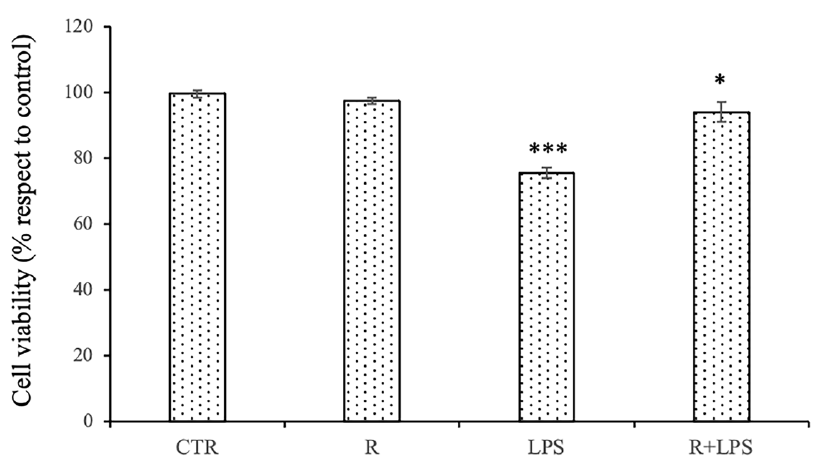
Figure 1. Effects of resveratrol and LPS treatment on cell viability. N13 microglial cells were treated with resveratrol (10 µ M) alone or in presence of LPS (100 ng/mL) for 72 h. Cell viability was evaluated by MTT test. Untreated cells used as control (CTR); cells treated with resveratrol (R); cells stimulated with LPS (100 ng/mL) alone (LPS); cells pre-treated with resveratrol before LPS stimulation (R + LPS). Experimental treatments were analyzed in triplicate, and data are expressed as the mean ± SD of five independent experiments. *** p < 0.001 LPS vs. CTR; * p < 0.05 R + LPS vs. LPS.